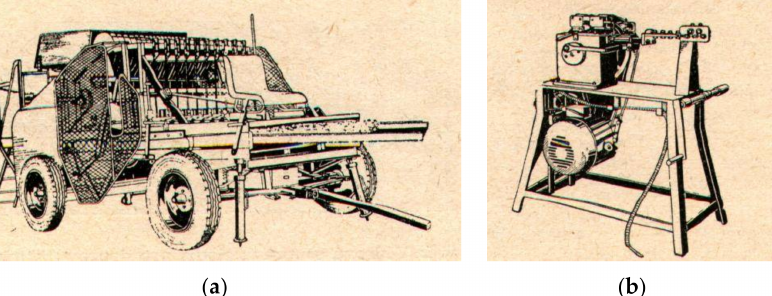
Figure 2. Parts of the mobile technological line for manufacturing SOLOMIT in Czechoslovakia, consisting of: ( a ) a press for manufacturing SOLOMIT panels LS-140, and ( b ) AS-50 automatic staple-making machine